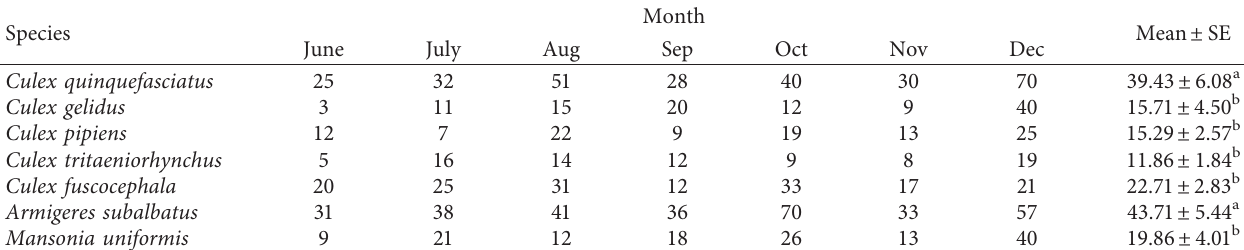
Table 3: Monthly mean density of mosquito larval species.